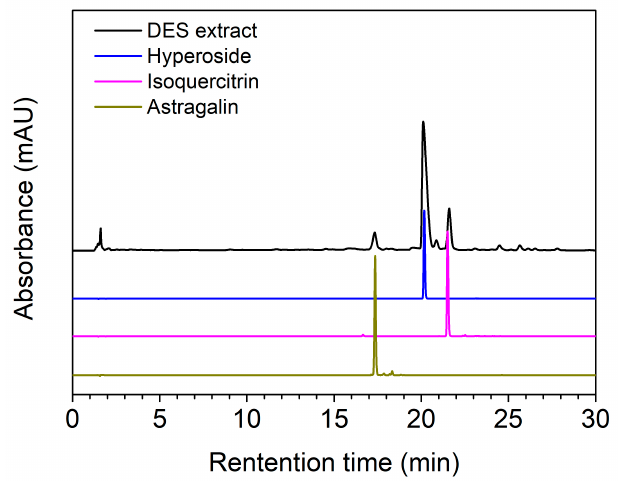
Figure 6. The chromatograms of the DES extract (black line), hyperoside (blue line), isoquercitrin (violet line), and astragalin (dark yellow line).